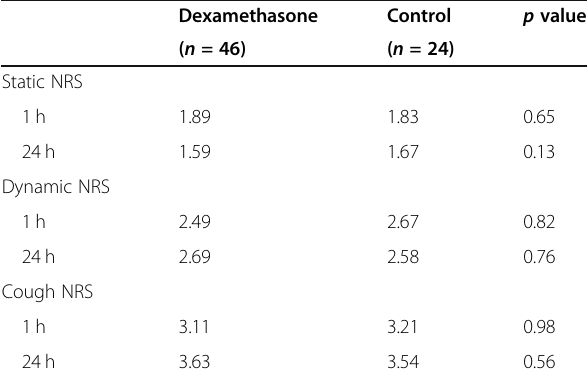
Table 2 Pain scores